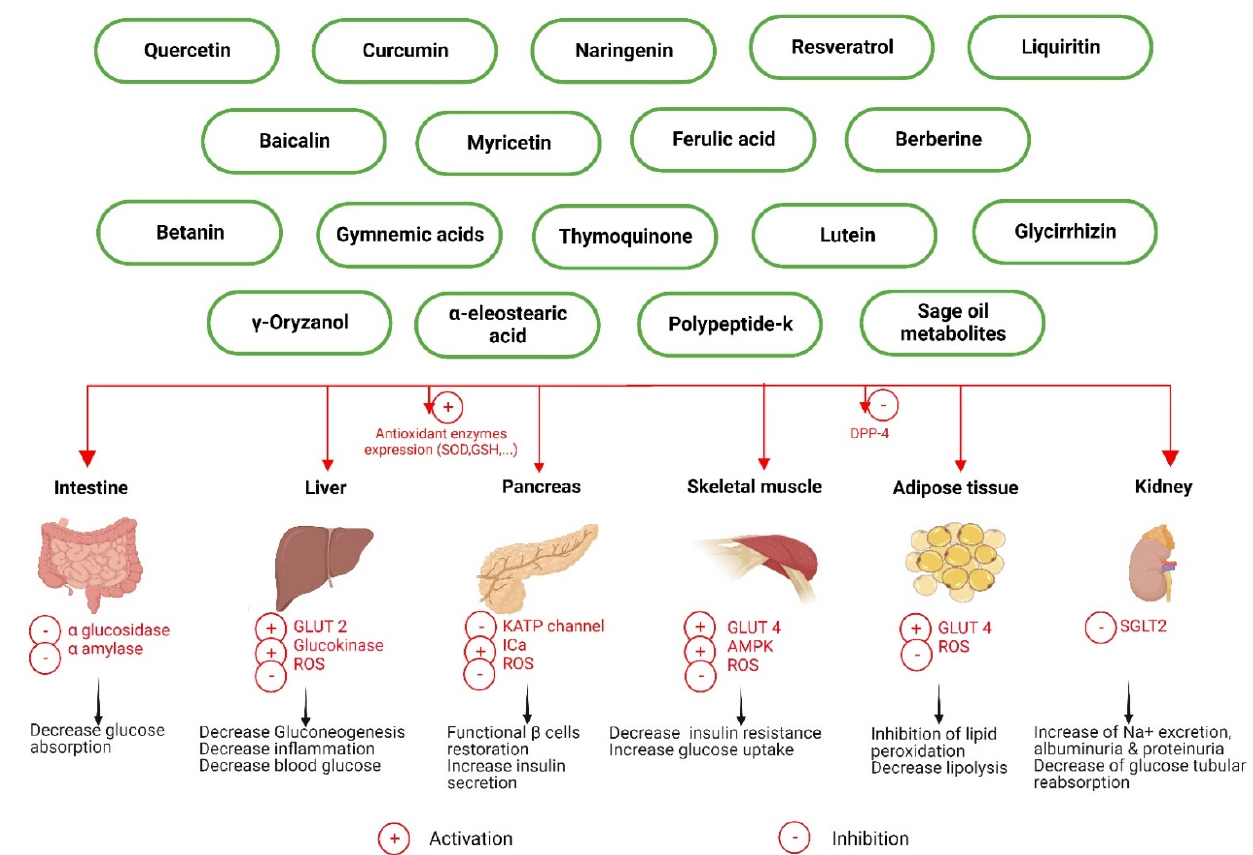
Figure 1. Various mechanisms and antidiabetic effects of some plant compounds (SOD—super oxide dismutase, GSH—glutathione, DPP-4—dipeptidyl peptidase 4, GLUT 2—glucose transporter 2, ROS—reactive oxygen species, KATP—adenosine triphosphate-sensitive potassium, ICa—calcium ion influx, GLUT 4—glucose transporter 4, AMPK—adenosine monophosphate-activated protein kinase, SGLT2—sodium-glucose cotransporter-2). Created with the use of